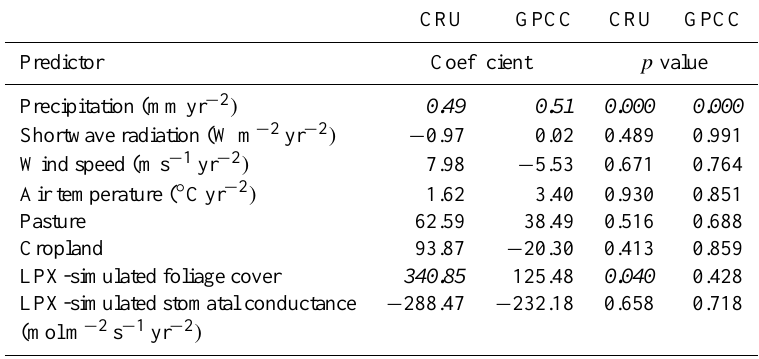
Table 2. Attribution of water balance ET trends (in mmyr − 2 ) in wet basins based on coefficients and p values from a multiple regression analysis, using CRU- and GPCC-based ET and precipitation, respectively. Significant p values ( ≤ 0.05) and coefficients are in italics.